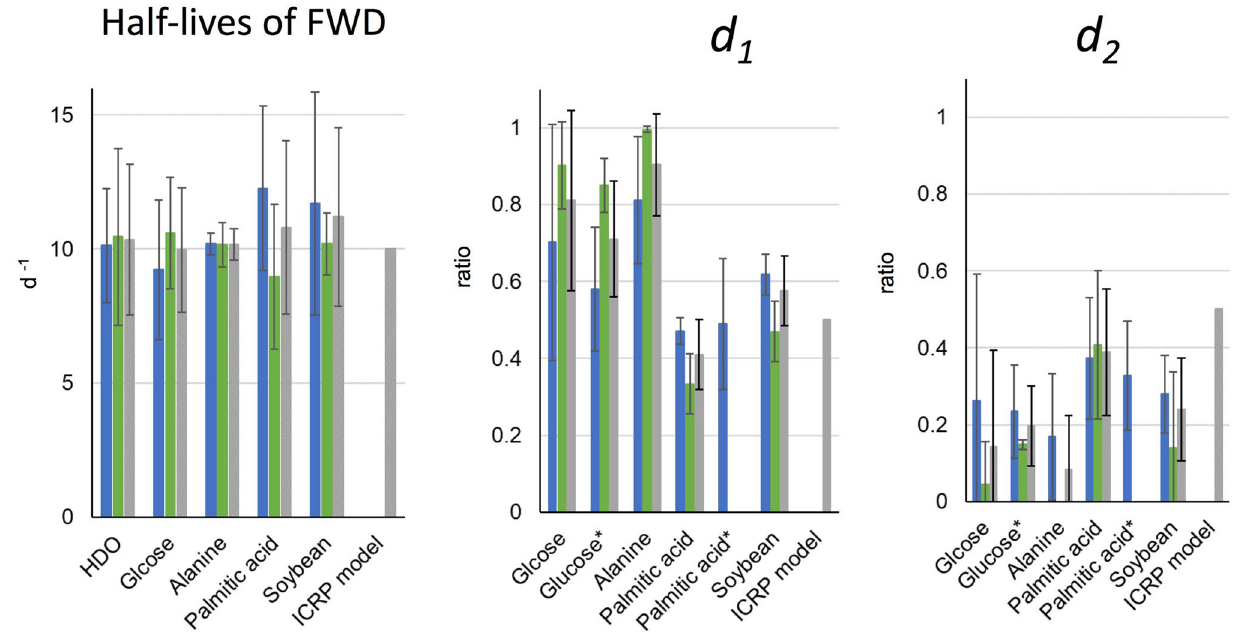
Figure 7. Biokinetic parameters of the OBD metabolic models. The model structure is shown in Fig. 1. Half- lives of FWD, the half-life of deuterium (D) in free water D (FWD) compartment among volunteers of each group; d 1 , distribution factor to FWD; d 2 , distribution factor to OBD compartment; blue, male volunteers; green, female volunteers; grey, all volunteers. Error bar shows the standard deviation among volunteers in each group. *The values obtained from 13 C-labelled compound administration experiments 31 . In those case, the ratios of the first and the second component of the exponential decrease in 13 C/ 12 C ratios in breath corresponded to d 1 and d 2 ,